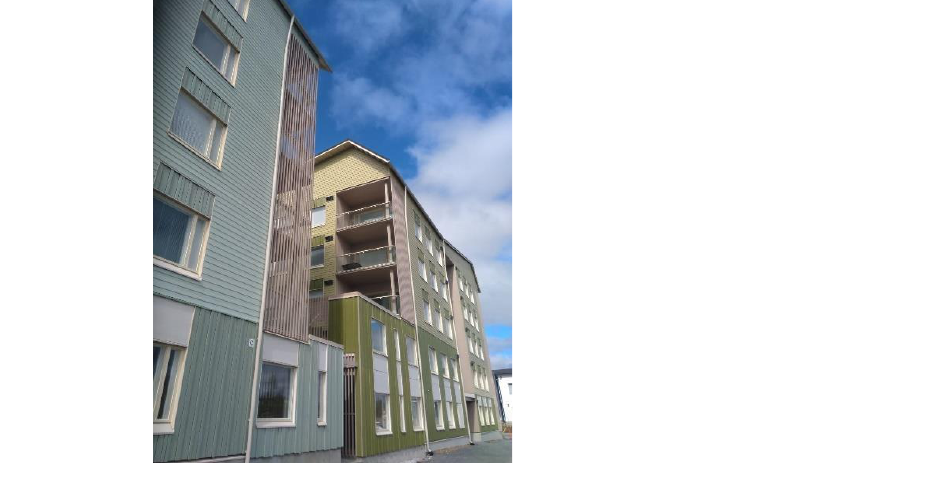
Figure 12. A-Kruunu Tampereen Honkakuusenkatu 5/Aihkinkatu 6 (photo courtesy of Suomen metsäkeskus).